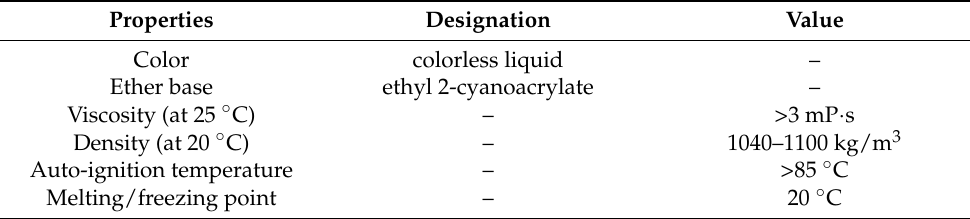
Table 2. Selected properties of cyanoacrylate adhesive [21].